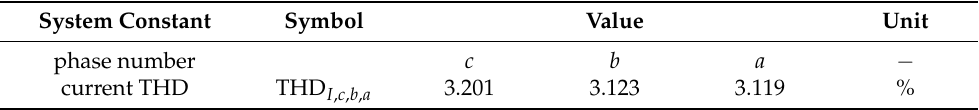
Table 4. Phase current THD for all